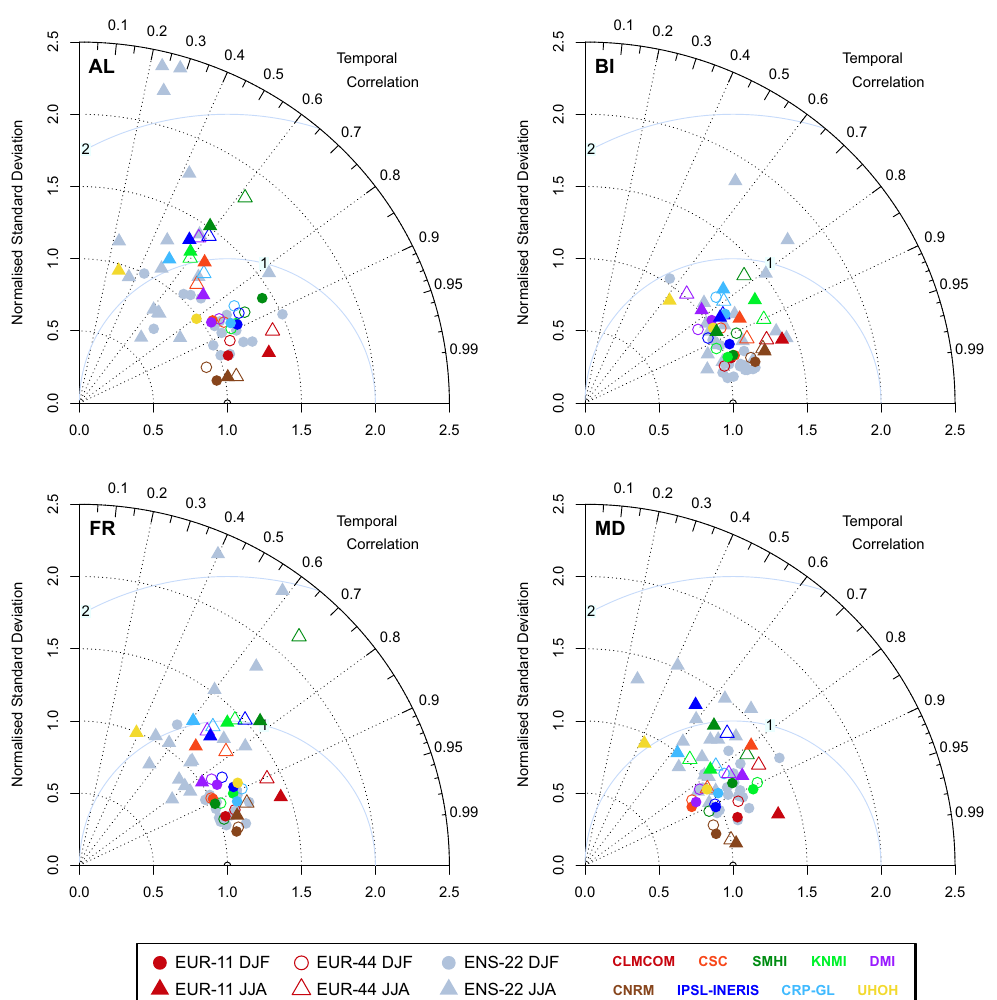
Figure B7. Temporal Taylor diagrams exploring the model performance with respect to the interannual temporal variability of mean winter (circles) and mean summer (triangles) temperature as averages over subdomains AL, BI, FR and MD (see Fig. 11 for subdomains EA, IP, ME and SC). Filled markers: EUR-11 ensemble, nonfilled markers: EUR-44 ensemble, gray markers: ENS-22 ensemble. The diagrams combine the temporal correlation of interannual variability (TCOIAV, cos(azimuth angle)) and ratio of interannual variability (RIAV, radius). The distance from the 1–1 location corresponds to the normalized and centered root-mean-square difference (which does not take into account the mean model bias), expressed as multiples of the observed standard